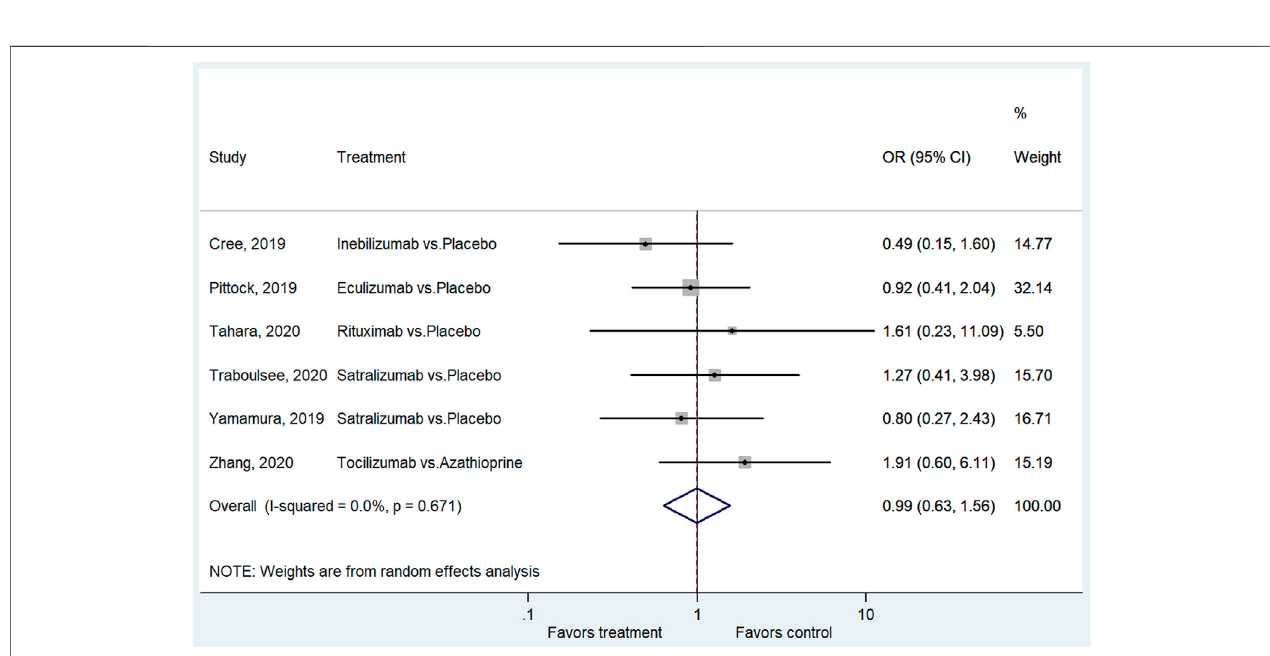
FIGURE 6 | Forest plot of the